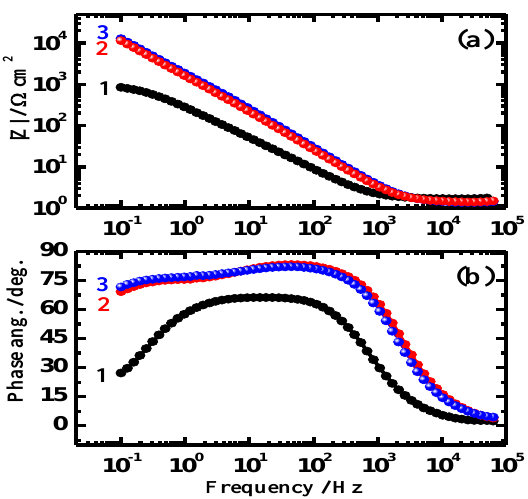
Figure 5. Typical Bode ( a ) impedance of the interface, |Z|; and ( b ) phase angle plots obtained for (1) hot swaged; (2) annealed at 800 °C; and (3) annealed at 940 °C Ti-45M electrodes after their immersion for 24 h in 2 M HCl solutions.